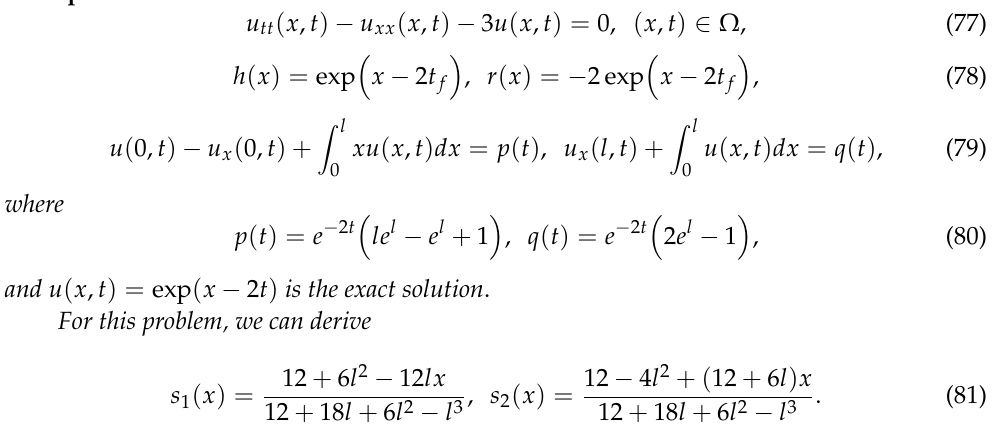
Figure 14. For Example 9 of the backward nonlocal wave problem under two-side nonlocal BCs: ME( u ) versus x with different final times.